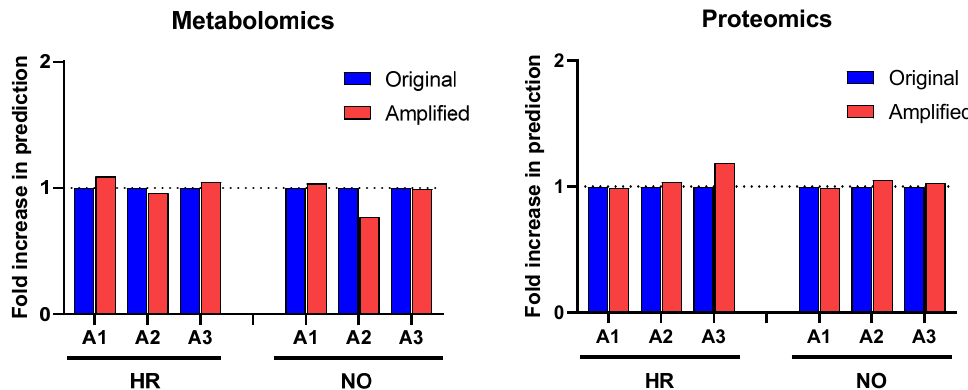
Figure 3. Comparison of prediction yields of diseases and functions identified in the amplified and original proteomics and metabolomics datasets by IPA based on published literature available in its knowledge database as of the time of performing the analysis (https://go.qiagen.com/IPA-transcriptomics-whitepaper, accessed on 27 August 2022). Total numbers of diseases and functions predicted in the amplified datasets are shown as fold-change (increase or decrease) in comparison to the original data for the HR and NO subject groups.